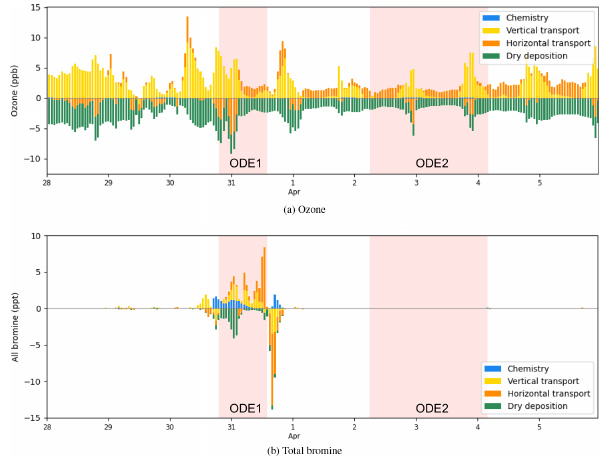
Figure 15. The process analysis of surface ozone and bromine species (Br, Br 2 , BrO, BrCl, HBr, HOBr, BrNO 2 , and BrONO 2 ) at Barrow from 28 March to 6 April